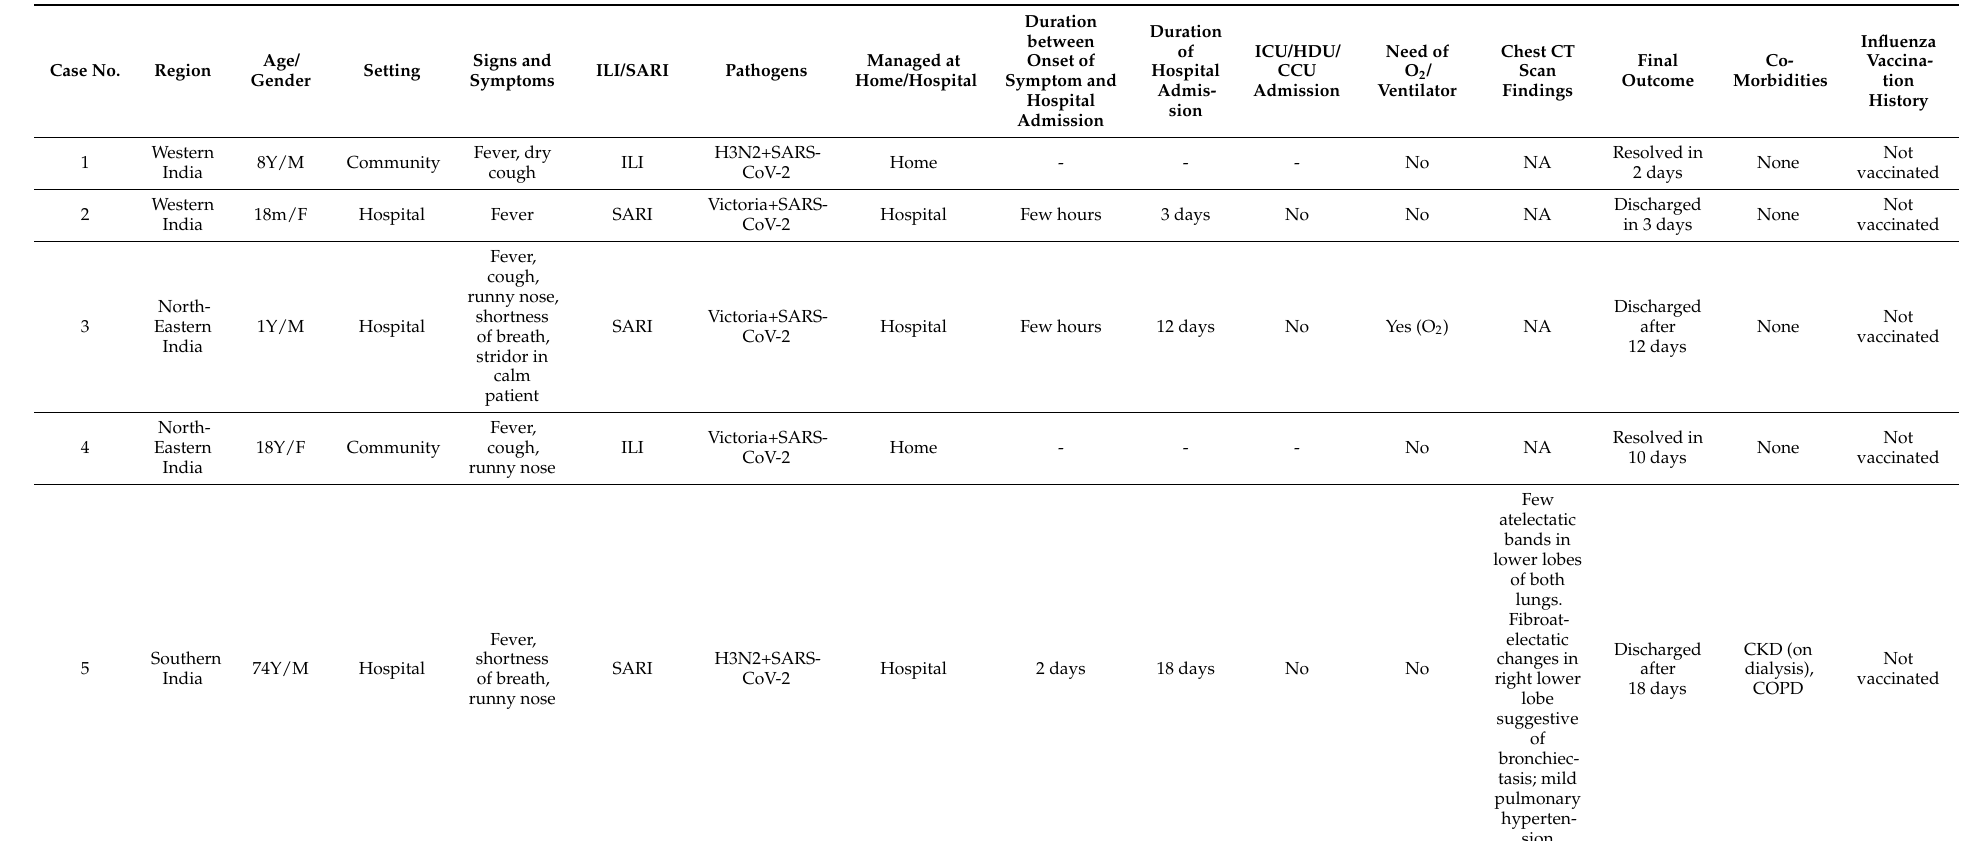
Table 1. Characteristics of the 5 individuals with COVID-19/influenza